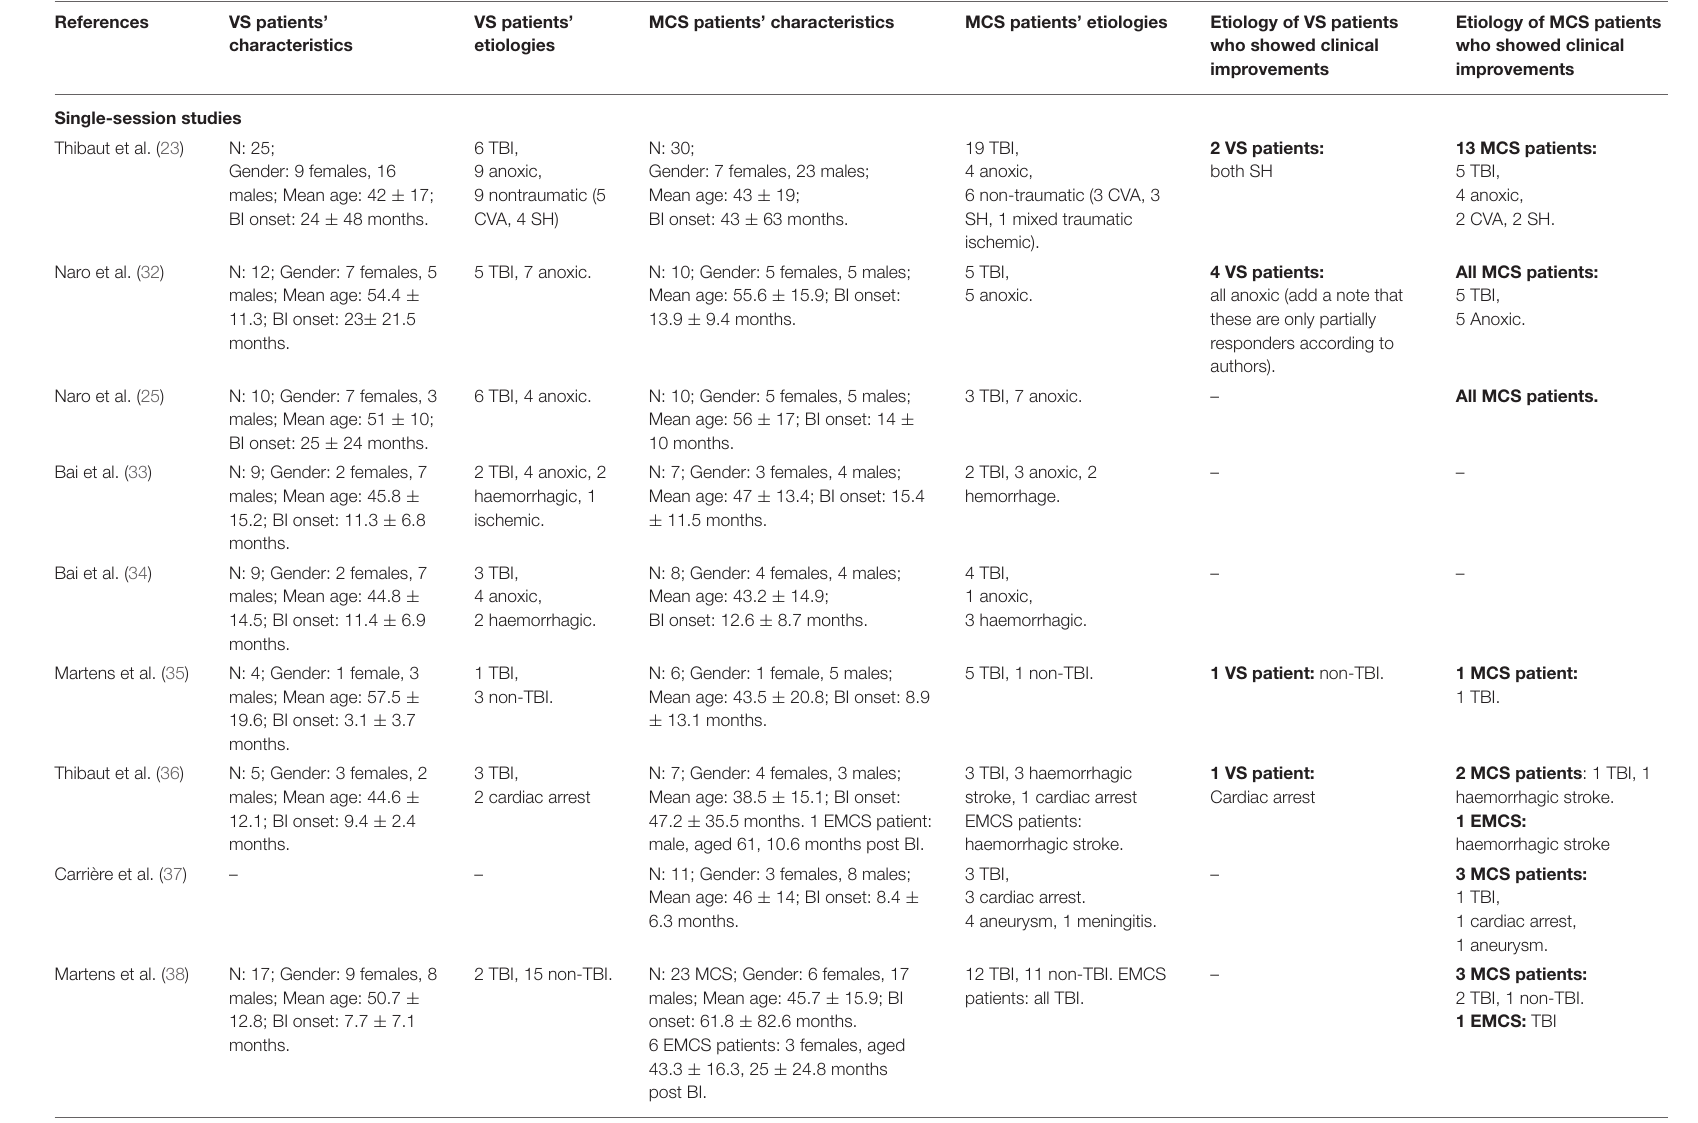
TABLE 3 | Demographics and etiologies of VS and MCS patients included in the different